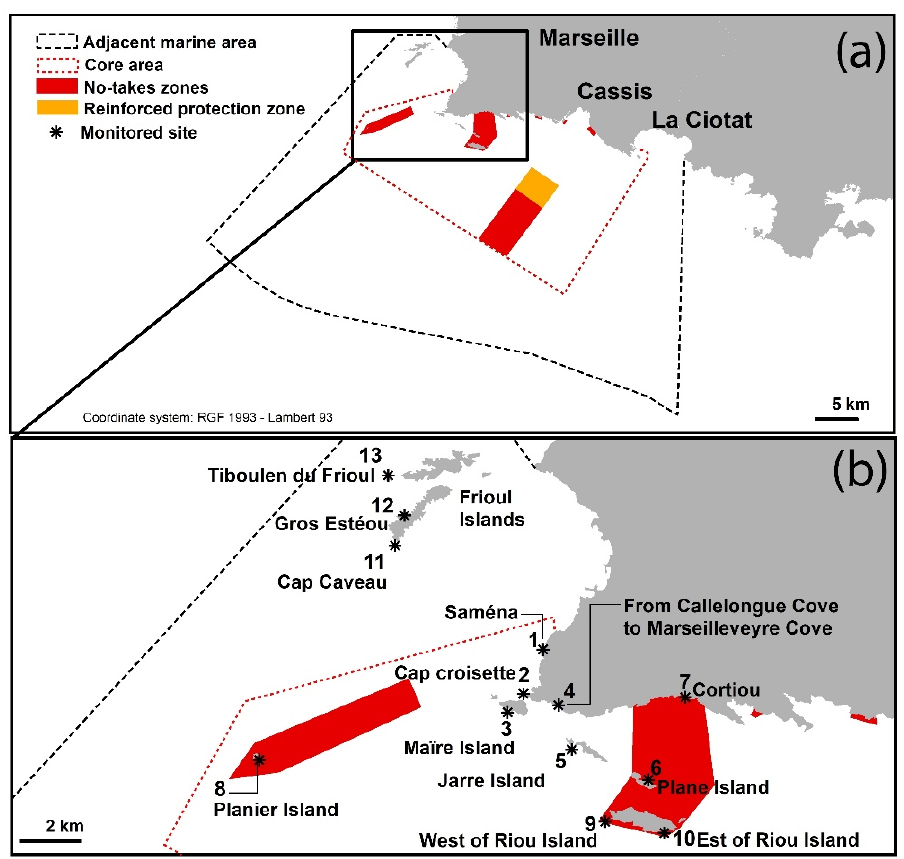
Figure 1. Calanque National Park (CNP), with boundaries and zoning ( a ) and monitored sites ( b ).